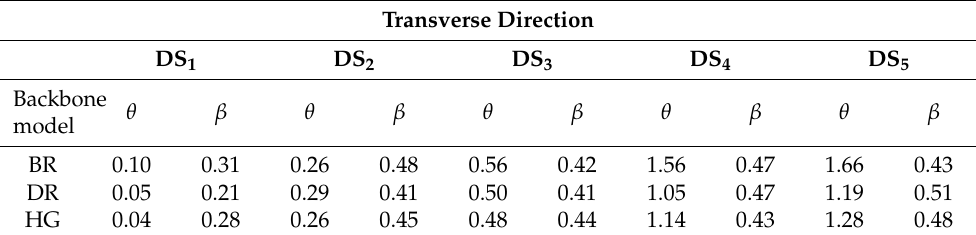
Table 5. Lognormal fragility curve parameters in the transverse